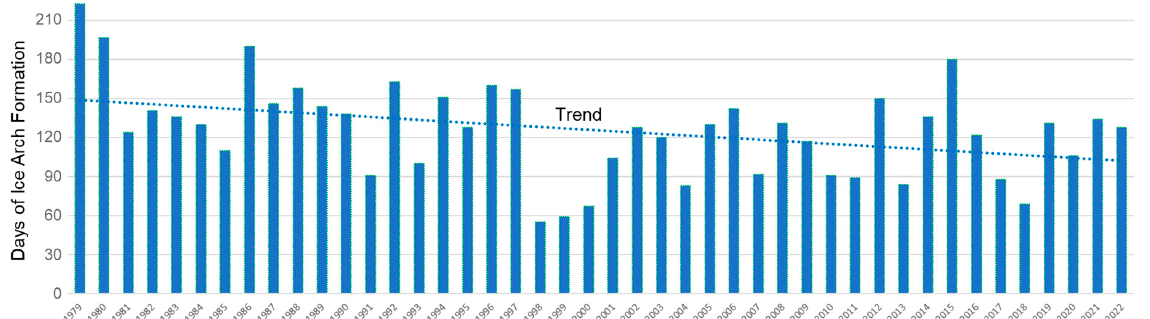
Figure 8. Duration in days of the Lancaster Sound ice arch for 1979 to 2022. Interannual variations in ice arch duration predominate the record (R 2 = 0.1492), but the overall trend is a reduction of 48 days, which is statistically significant ( p -value = 0.0100).